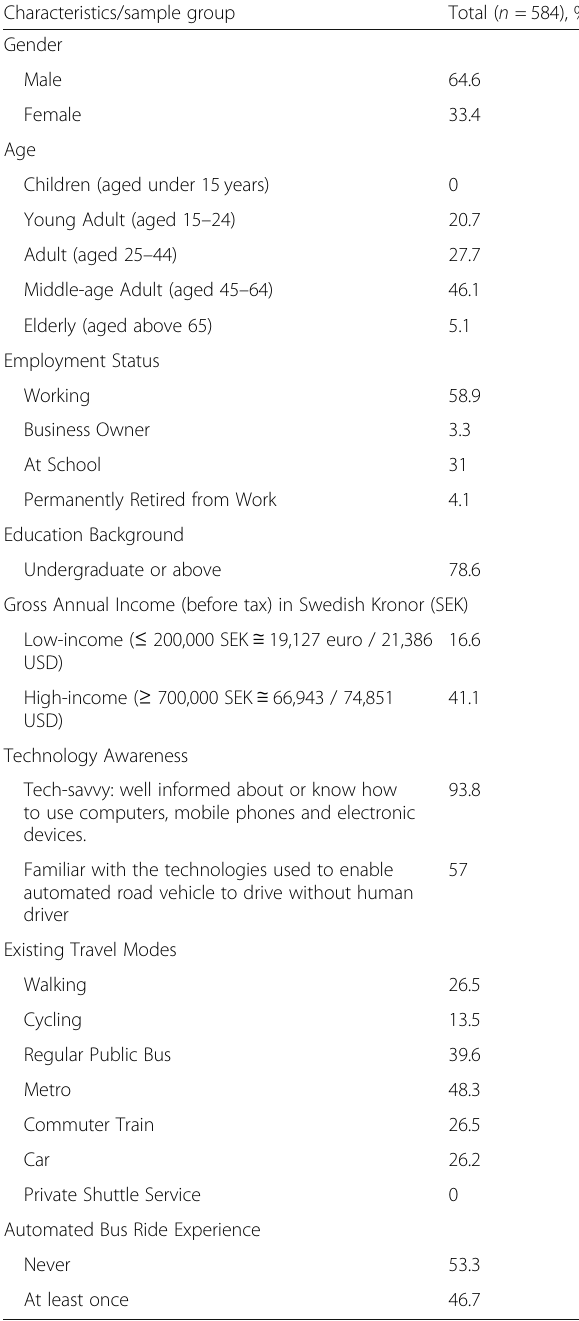
Table 1 Distribution of socio-demographic characteristics of